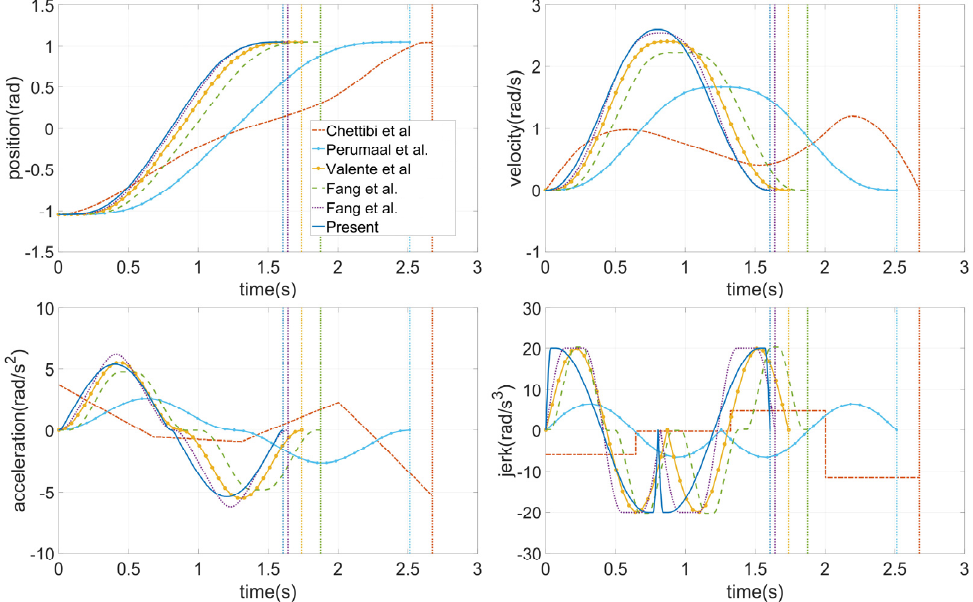
Figure 6. Motion profiles of joint 4 for different trajectory models.